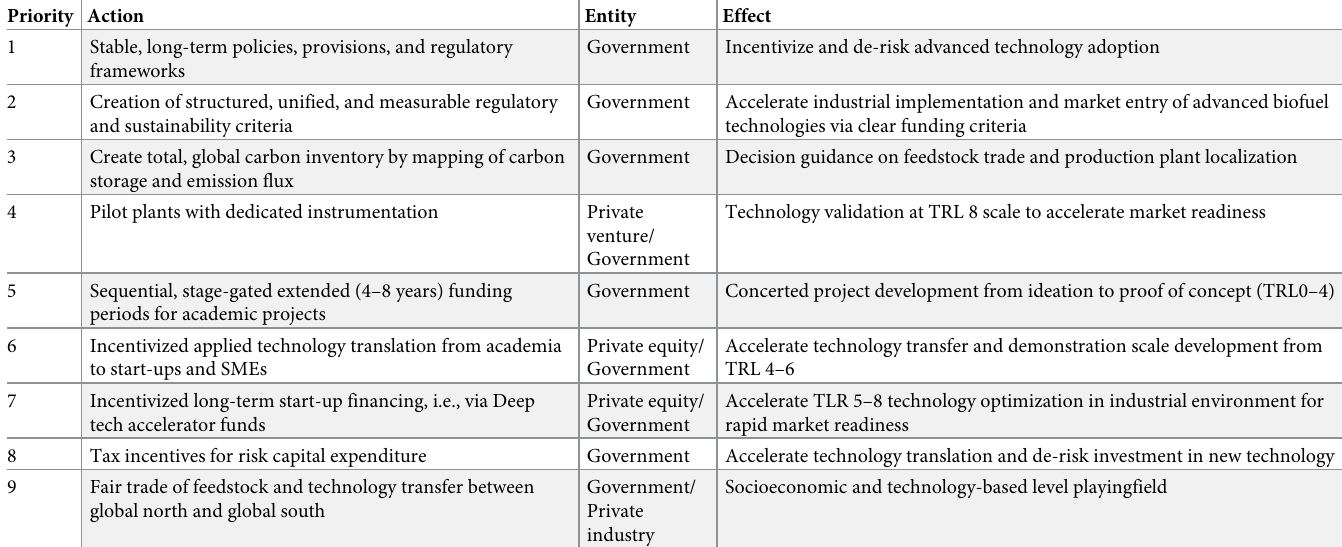
Table 2. Summary of policy recommendation and expected